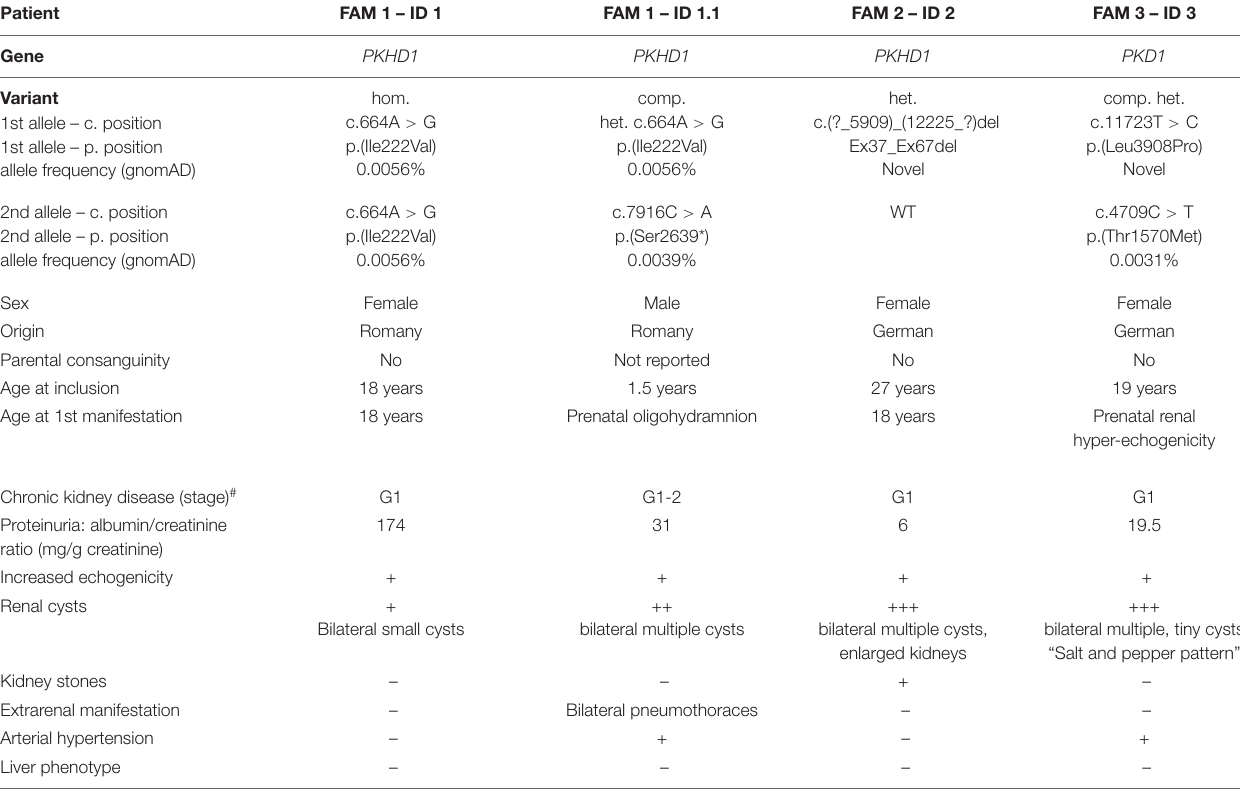
TABLE 1 | Phenotypic and genotypic characteristics of patients included in this case